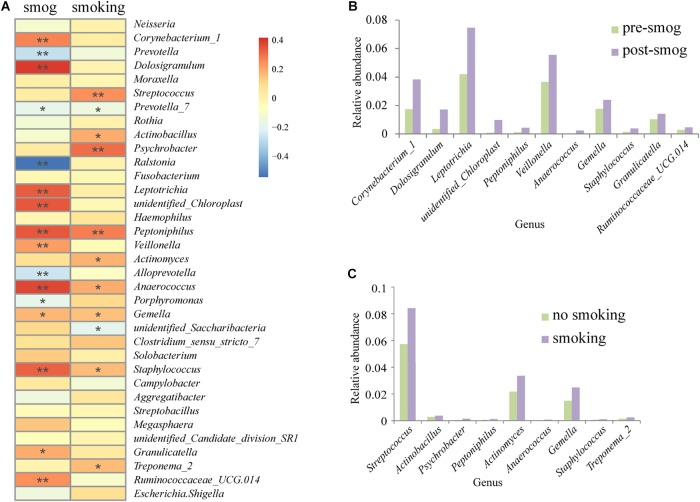
Correlation analysis of smog and smoking with the genera of the pharyngeal microbiota. (A) Spearman correlation analysis of influential factors and genera. ∗p < 0.05, ∗∗p < 0.001. (B) The abundance of eleven genera with positive correlations with smog. (C) The abundance of nine genera with positive correlations with smoking.